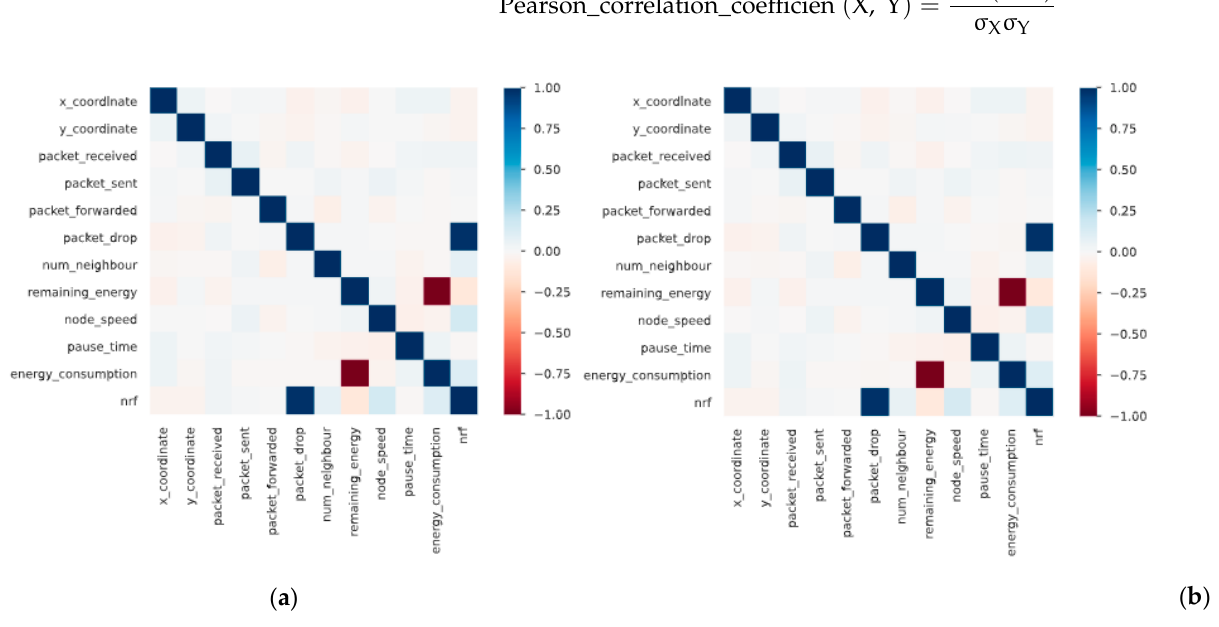
Figure 9. Pearson ( a ) and spearman ( b ) correlation matrix.